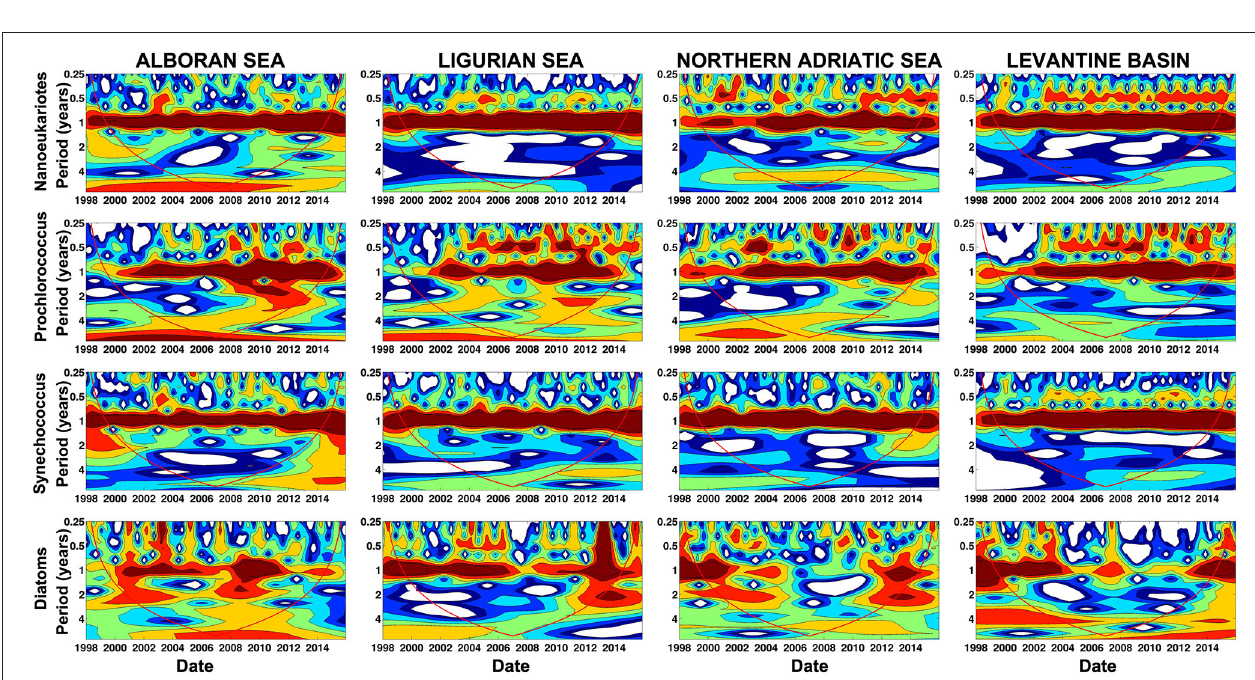
FIGURE 11 | Continuous wavelet power spectrum for the 10-day time series for each group and four sub-regions. Each row represents each phytoplankton group (nanoeukaryotes, Prochlorococcus , Synechococcus, and diatoms) and each column corresponds to the same sub-region (Alboran Sea, Ligurian Sea, Northern Adriatic Sea, and Levantine Basin). Red line indicates the region of time and frequency affected by the edges of the data and should not be considered.